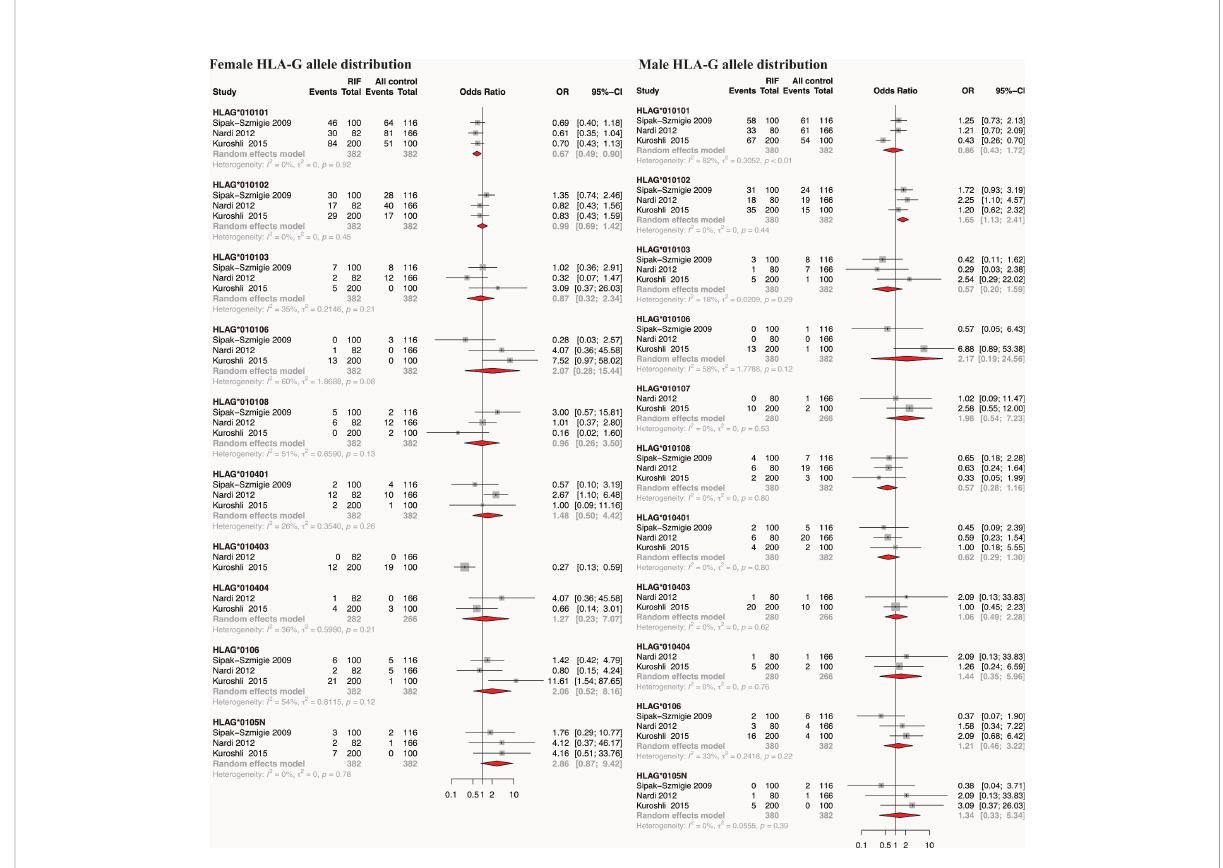
FIGURE 5 Forest plot showing the association of parental HLA-G allele distribution with RIF.